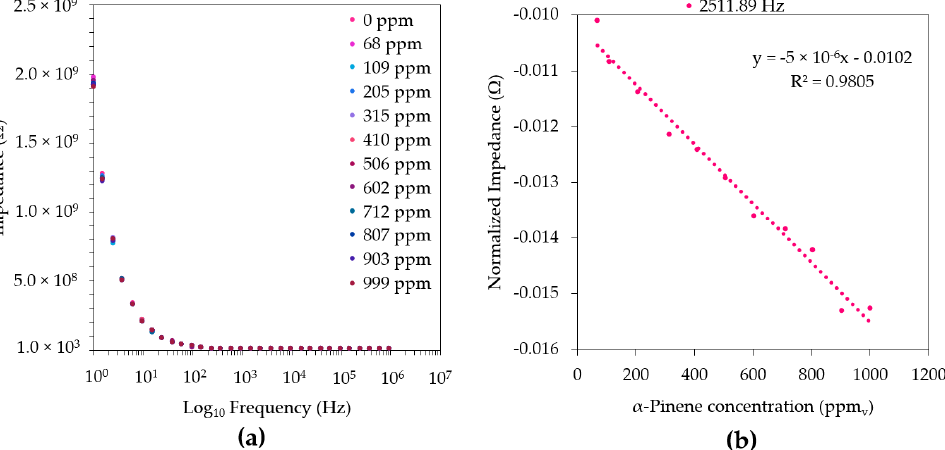
Figure 2. Impedance spectra of a (PAH/GO) 5 -film-based sensor ( a , b ) with its normalized impedance ( Ω ) spectra at a fixed frequency (2511.89 Hz) for detecting different α -pinene concentrations in air. The average and standard deviations of the respective impedance data of the duplicates were used for the normalization (Supplementary Materials, Table S9).